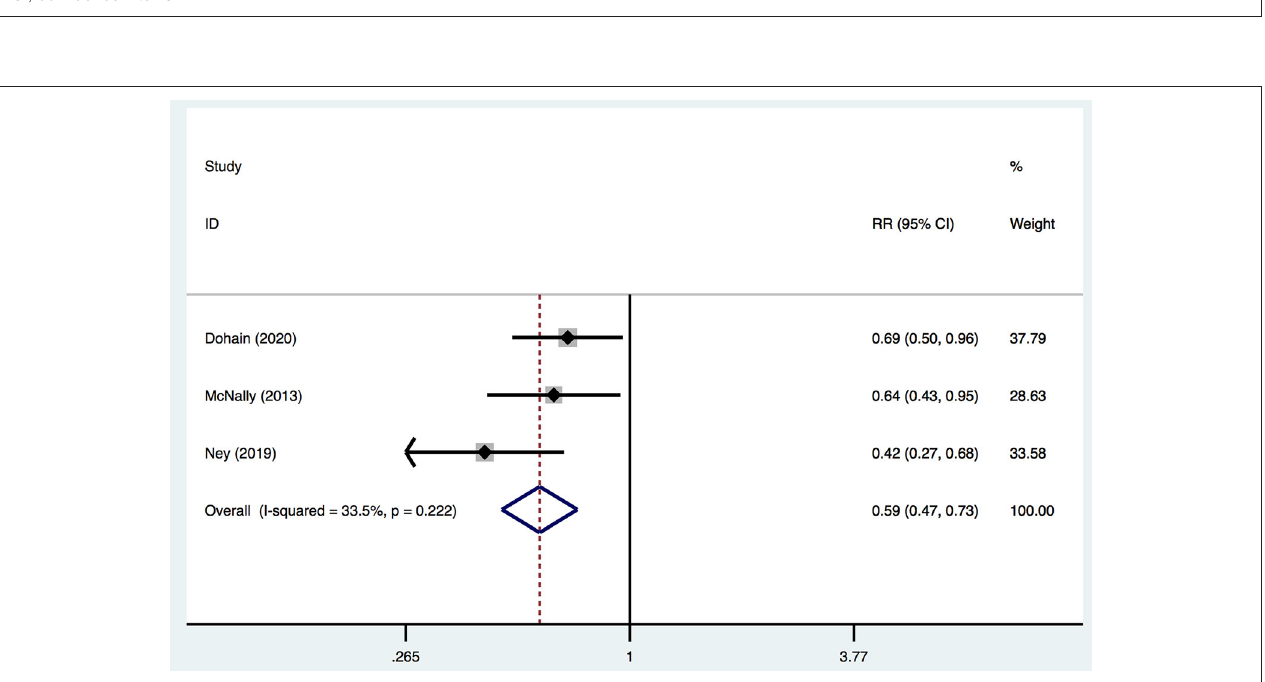
FIGURE 4 | Forest plot for RRs of VitD deficiency rate of pre- and 24-h post-cardiac surgery identified in the meta-analysis of three trials using fixed-effect model. Only the first author of each study is given. Test for overall effect, z = 4.69, P = 0.00; test for heterogeneity, I 2 = 33.5%, P = 0.22. RR, risk ratio. CI, confidence interval.